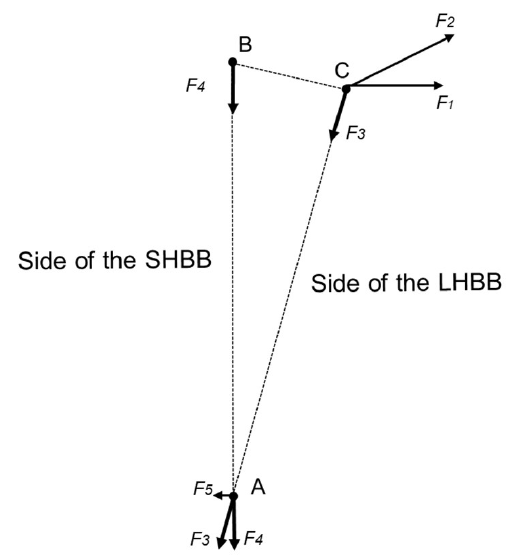
Figure 5. The forces that act on the biceps brachii tendons during external rotation. A: Confluence between the LHBB and SHBB. B: Lateral side of the SHBB at the top of the coracoid process level. C: Medial side of the LHBB tendon at the top of the lesser tubercle level. F1 : Outward force of the LHBB due to external rotation. F2 : Component force of F1. F3 : Component force of F1; tension in the distal direction applied to the LHBB. F4 : Component force of F3; tension in the distal direction applied to the SHBB. F5 : Component force of F3. LHBB, long head of biceps brachii; SHBB, short head of biceps